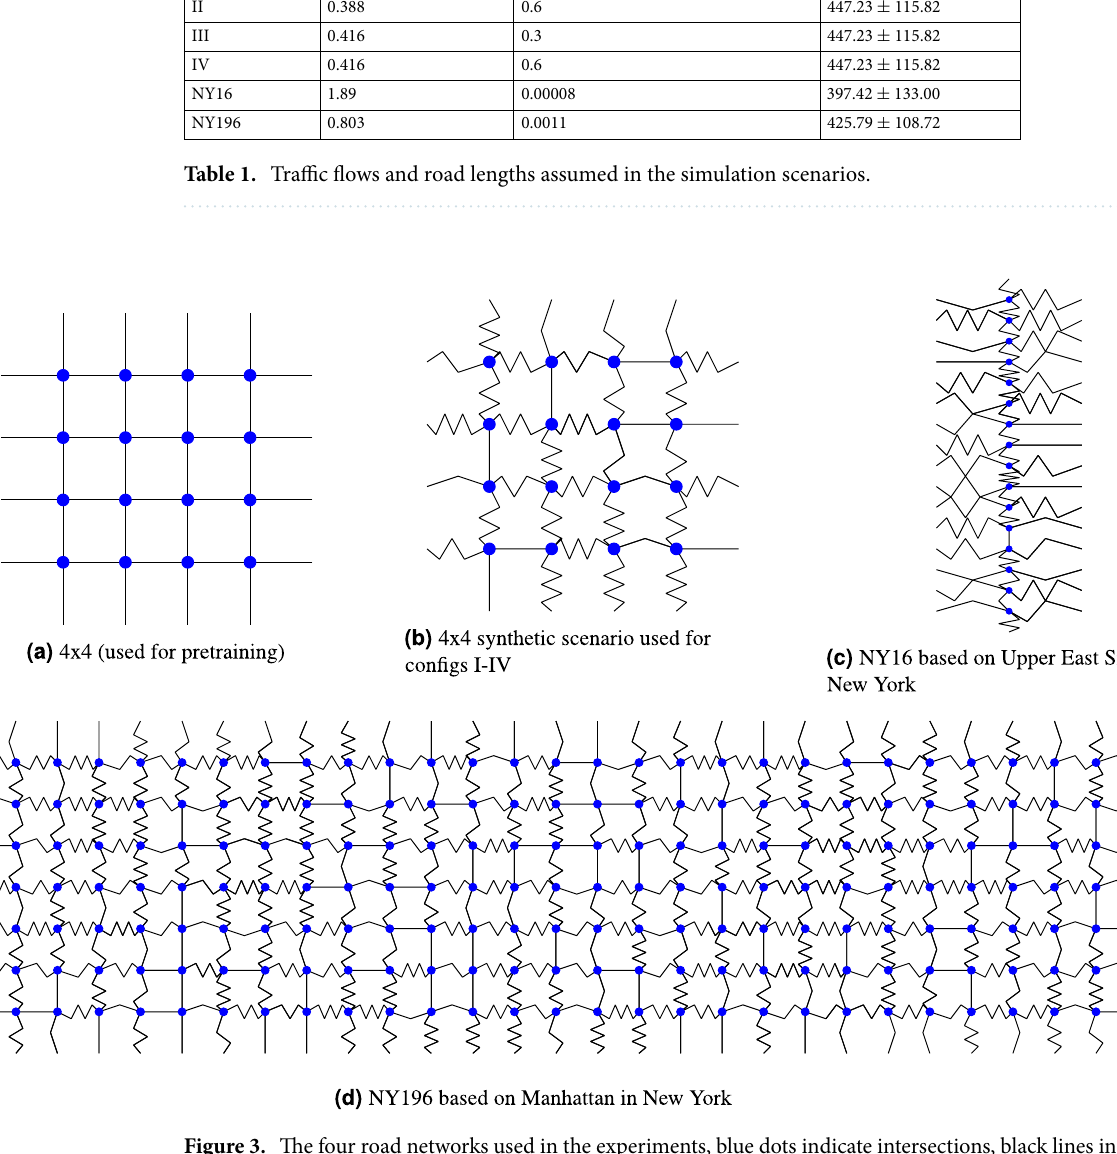
Figure 3. The four road networks used in the experiments, blue dots indicate intersections, black lines indicate roads. Note the varied lengths of the roads in ( b – d